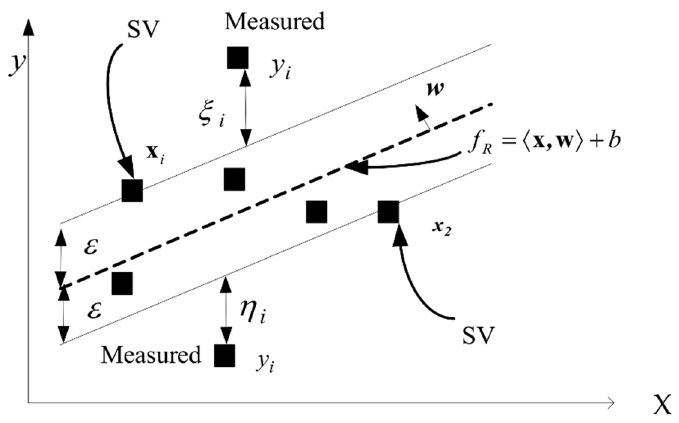
Figure 1. The concept of linear SVM with SVs.